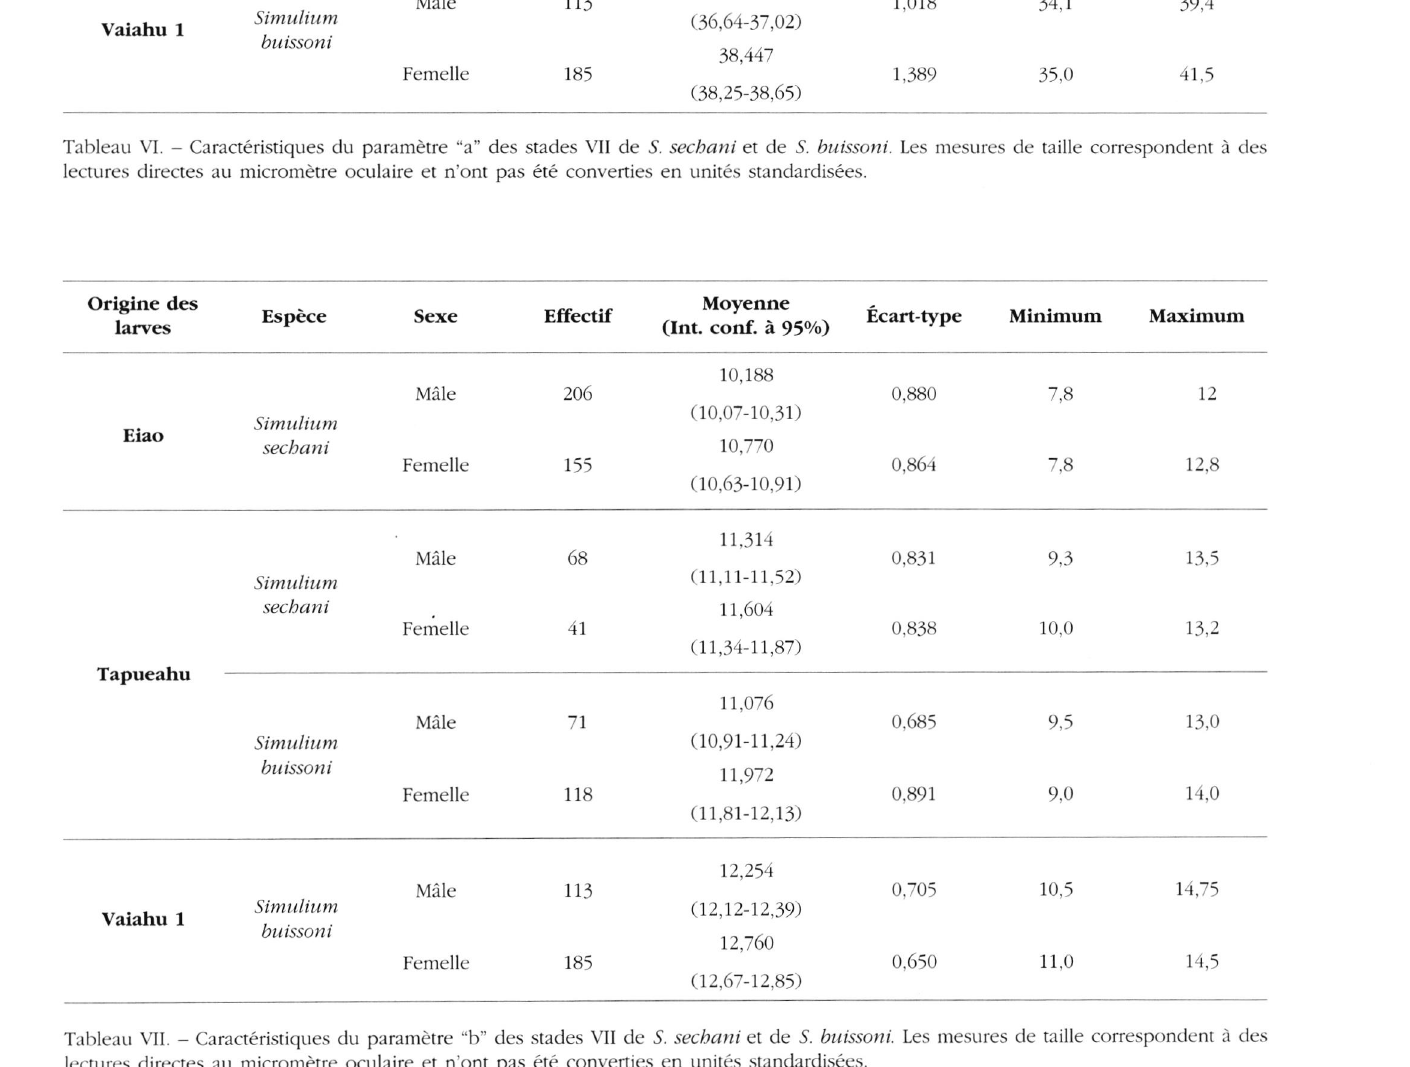
Tableau VII. - Caractéristiques du paramètre "b" des stades VII de S. sechani et de S. buissoni. Les mesures de taille correspondent à des lectures directes au micromètre oculaire et n'ont pas été converties en unités standardisées. Parasite, 2001, 8,